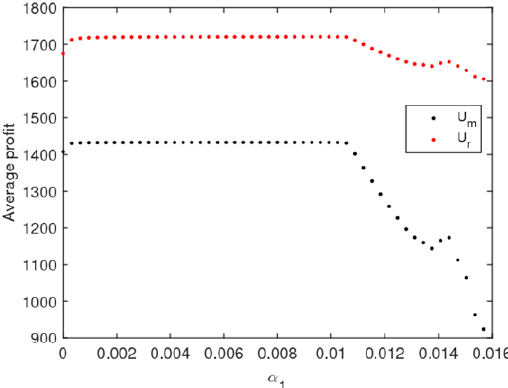
Figure 13. The average utilities of the manufacturer and retailer with 𝛼 (cid:2869) changing.